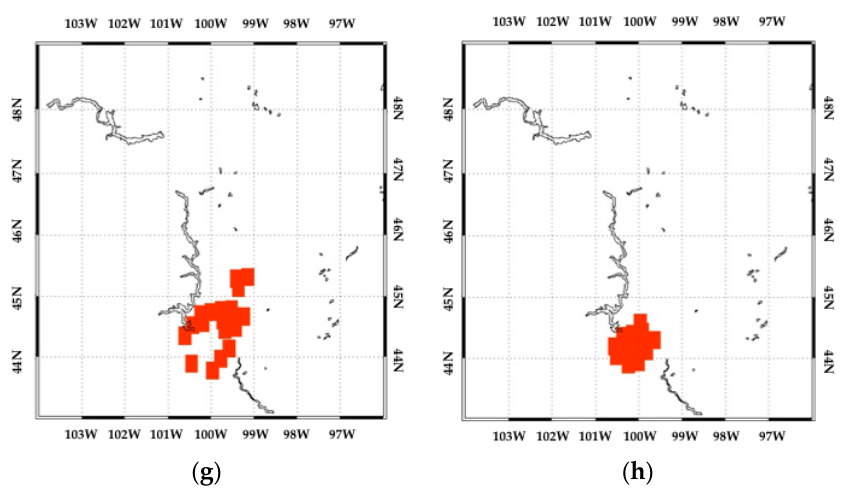
Figure 5. TB var sensitivity classes applied to the hailstorms over Colorado ( a – d ) and South Dakota ( e - f ). The sequencing of CO3 complete domain ( a , e ) using the TB var thresholds identifies the majority of convective pixels in the class 15%–25% ( b , f ) while classes with TB var values ranging in 25–35% ( c , g ) and > 35% ( d , h ) enclose the main hail cores. Note that no pixels belong to the class TB var > 35% for the Colorado hailstorm where the measured hail diameter at ground was lower than 3.5 cm.